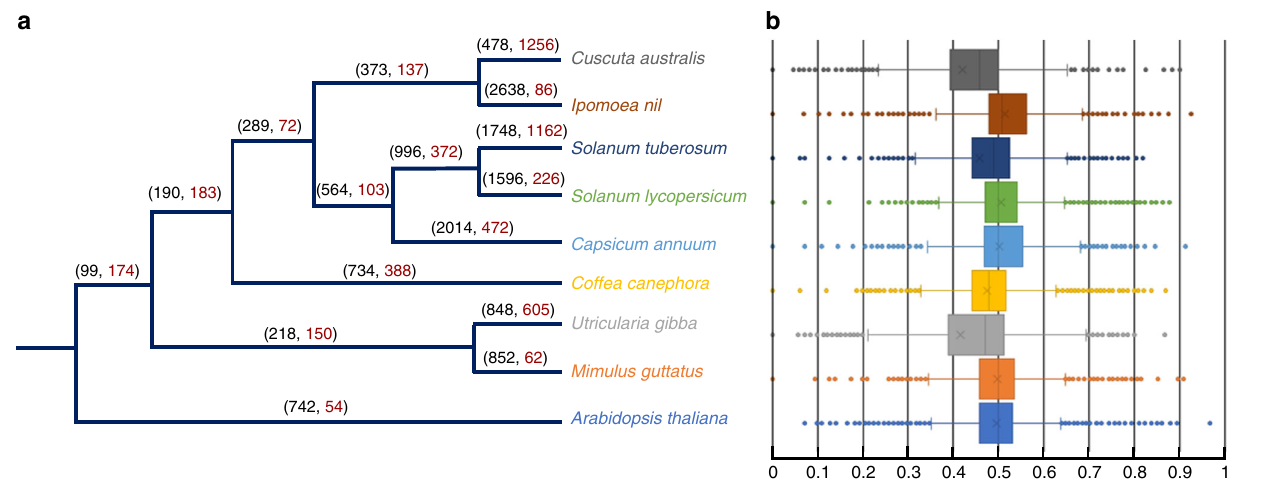
Fig. 2 Expansion and contraction in C. australis gene families. a Signi fi cantly expanded and contracted gene families. Brackets above each branch indicate numbers of expanded (in black, before comma) and contracted (in red, after comma) gene families. b Tukey boxplot overview of the differences among the gene numbers of the conserved gene families, based on the F -index values ( F -indices range from 0 to 1; when F = , < , or > 0.5, the gene number in the given gene family is equal to, smaller, or greater than the average size of this gene family in all species). The left and right sides of the boxes are the fi rst and third quartiles, respectively; means and medians of the data are shown as an “ × ” and the bands in the boxes, respectively; for each box, the whiskers represent the smallest and biggest datum that are still within 1.5 times interquartile range of the lower and upper quartile, and the outliers are shown as